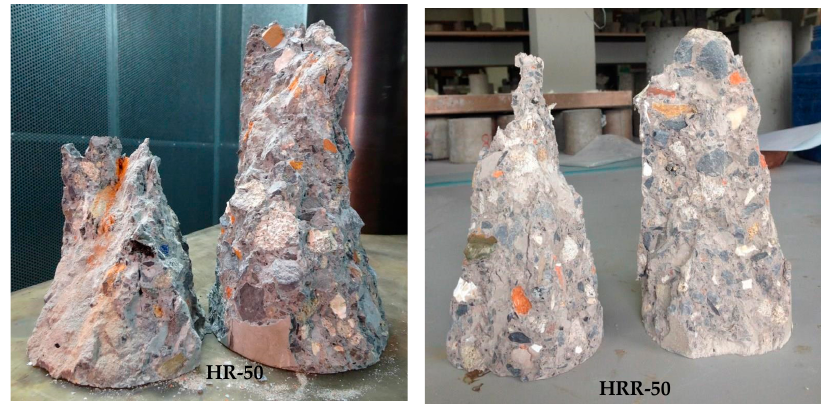
Figure 12. Fracture surface of samples broken during fatigue tests.